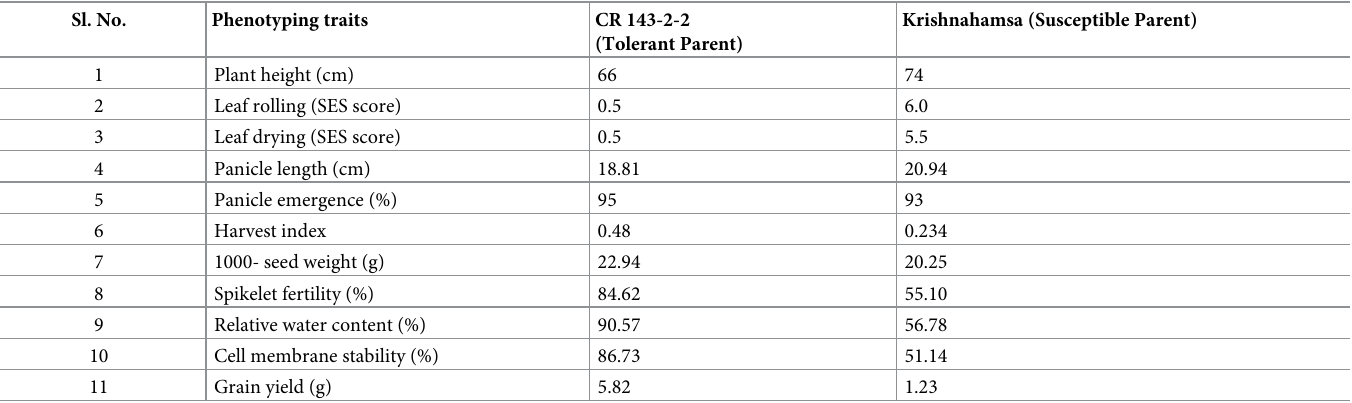
Table 3. Mean estimates of morpho-physiological traits in contrasting parents (CR143-2-2 and Krishnahamsa) under reproductive stage drought stress. Sl. No.